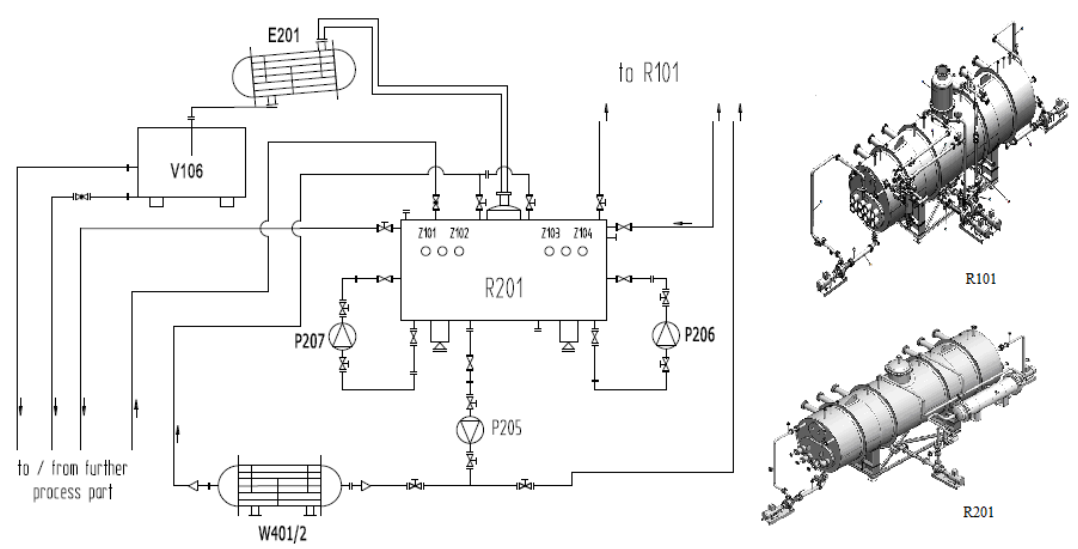
Figure 4. Simplified technological flowchart of extractor R201 in the depolymerization line.3.2. Extractor Unit with Auxiliary Equipment (Systems and Devices).